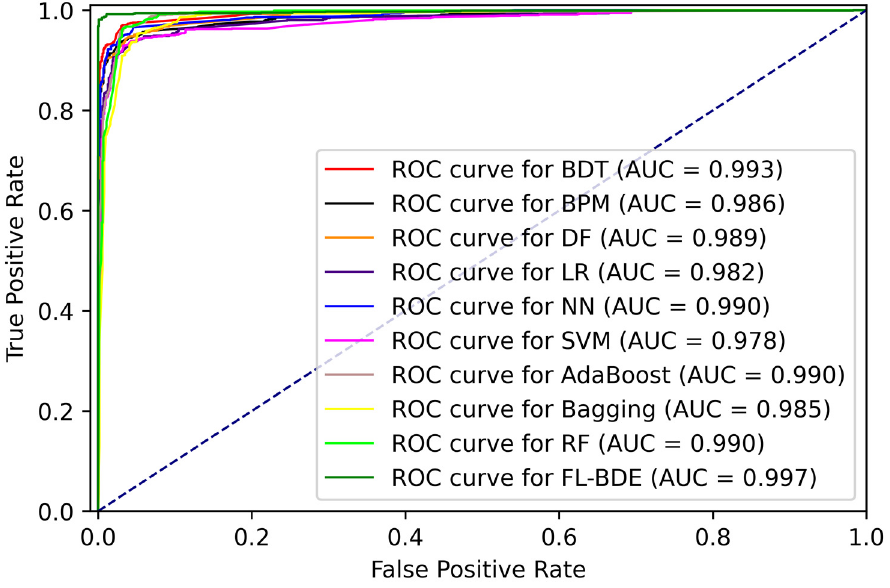
Figure 10. ROC curves of FL-BDE, ML- and EL-based models for 5-fold cross-validation. Table 5. A summary of the proposed model and the relevant studies in the literature and their per- formance results.